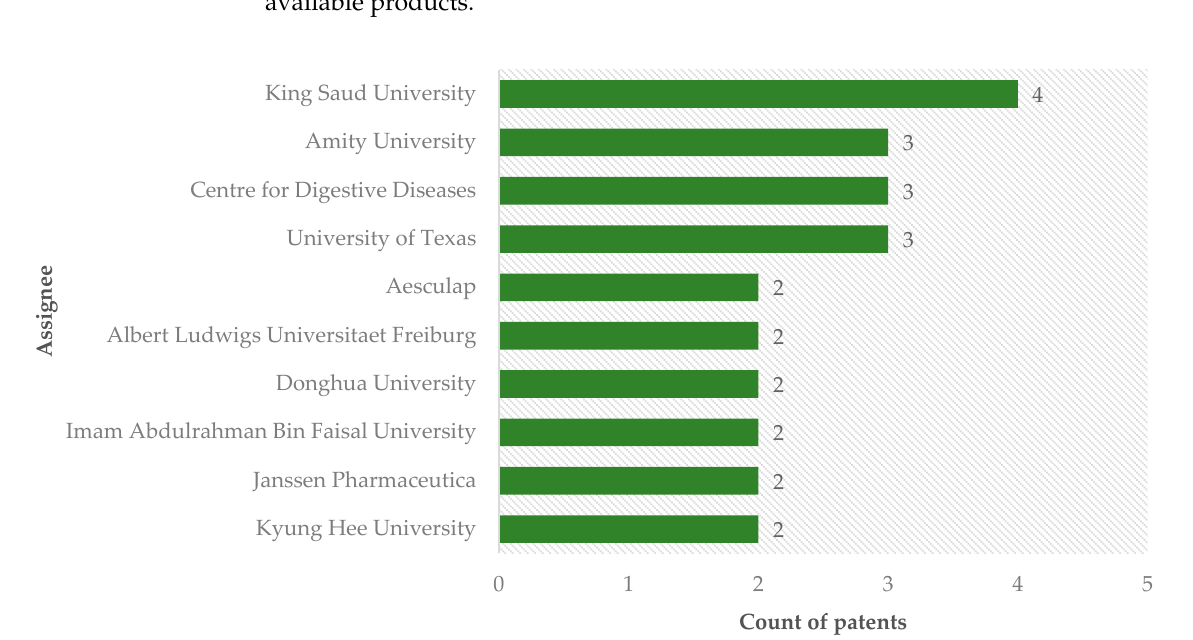
Figure 5. Patents issued on the use of silver nanoparticles in dentistry by depositors.